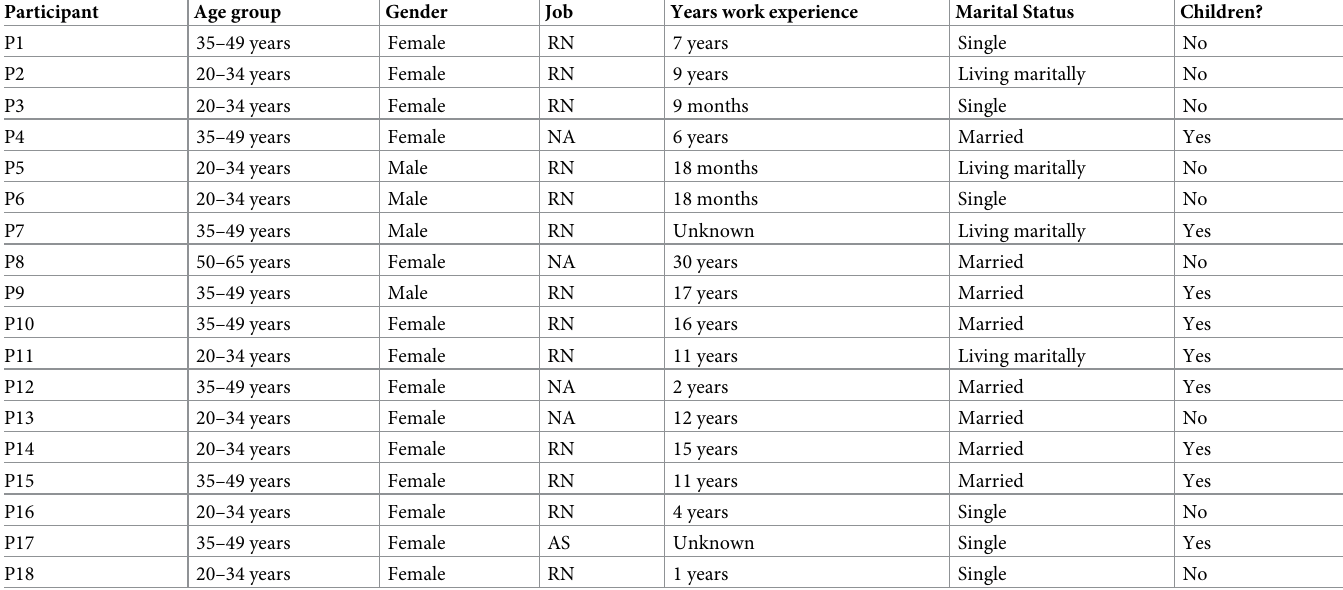
Table 1. Characteristics of the study population (N = 18).